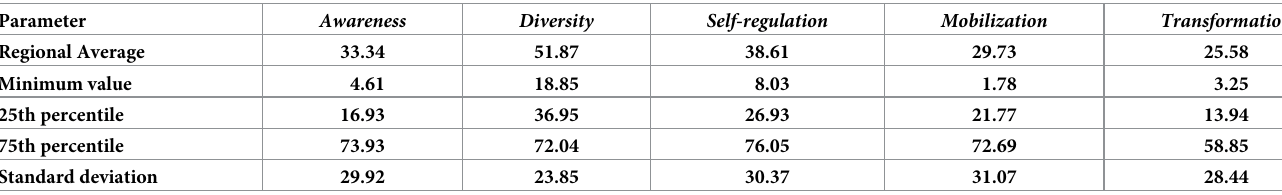
Table 4. Regional summary of inherent system resilience capacities. Parameter